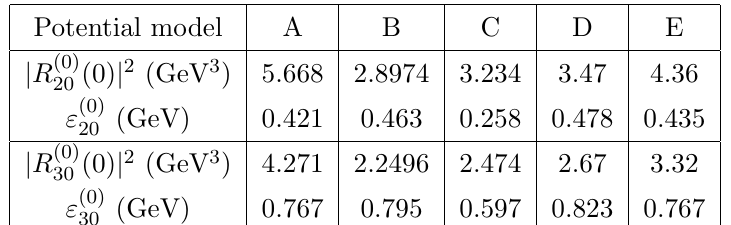
, of the bottomonium 2 S and 3 S n 0